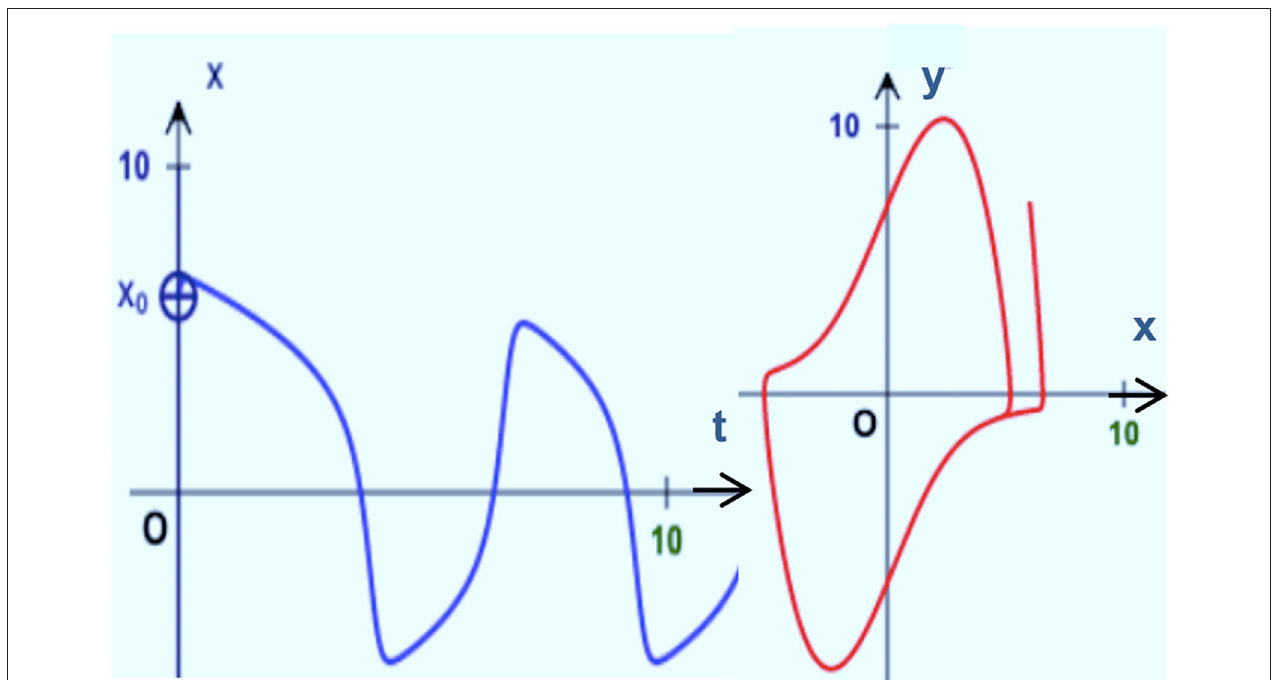
FIGURE 6 | Solution of (18) with ω